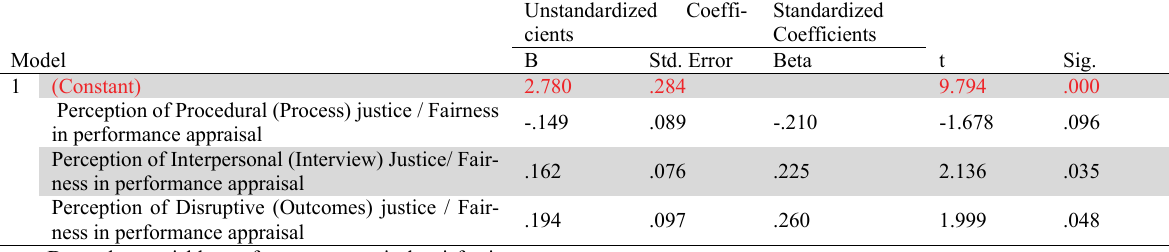
Unstandardized Coeffi- cients